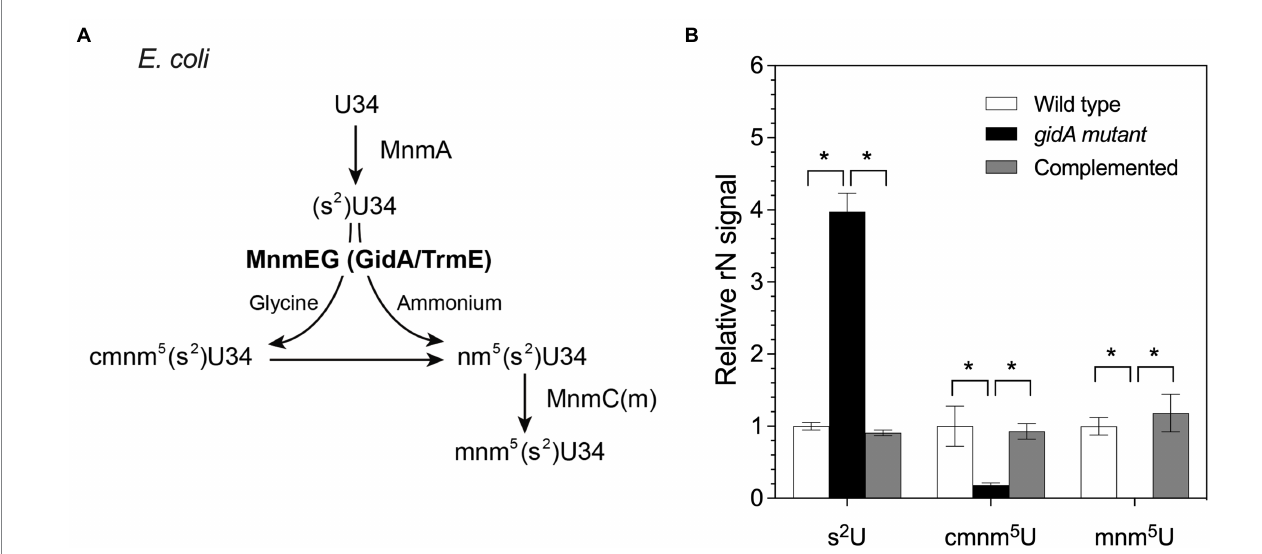
FIGURE 1 The amount of tRNA modifications in the mnm 5 (s 2 )U biosynthetic pathway is altered in the gidA mutant. (A) The pathway of mnm 5 (s 2 )U biosynthesis in E. coli . (B) Change in the levels of s 2 U, cmnm 5 U, and mnm 5 U in total tRNA isolated from wild-type, gidA mutant, and complemented strains. The wild type and gidA mutant carried the pBBR1MCS-4 plasmid as a vector control. The level of each modified ribonucleoside was quantified based on the MRM signal intensity and normalized by dividing the quantified amounts by the summed signals of adenosine, guanosine, cytidine, and uridine in the sample. The data represent the mean ± SD values of three biological replicates. The statistical analysis was performed using Graphpad Prism (GraphPad Software). Asterisks denote a significant difference in the one-way analysis of variance (ANOVA; * p ≤